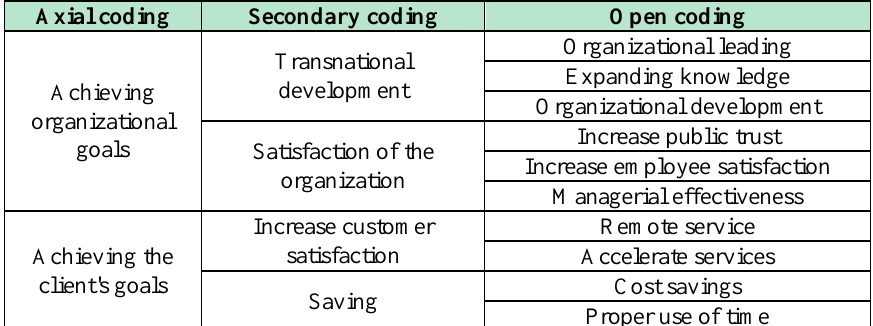
Table 5: Axial coding of qualitative data